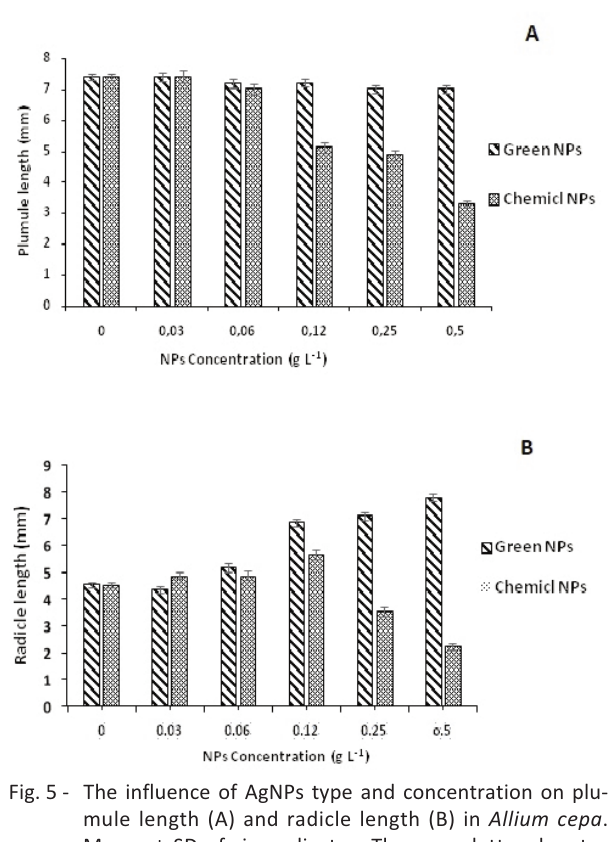
Fig. 5 ­ The influence of AgNPs type and concentration on plu­ mule length (A) and radicle length (B) in Allium cepa . Means ± SD of six replicates. The same letter denotes lack of a statistically significant difference (Tukey, p<0.01).